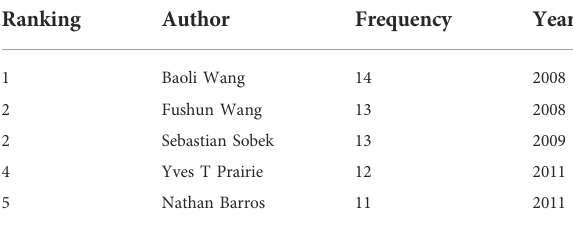
TABLE 4 Top fi ve most productive authors in GHG-HR research fi eld.